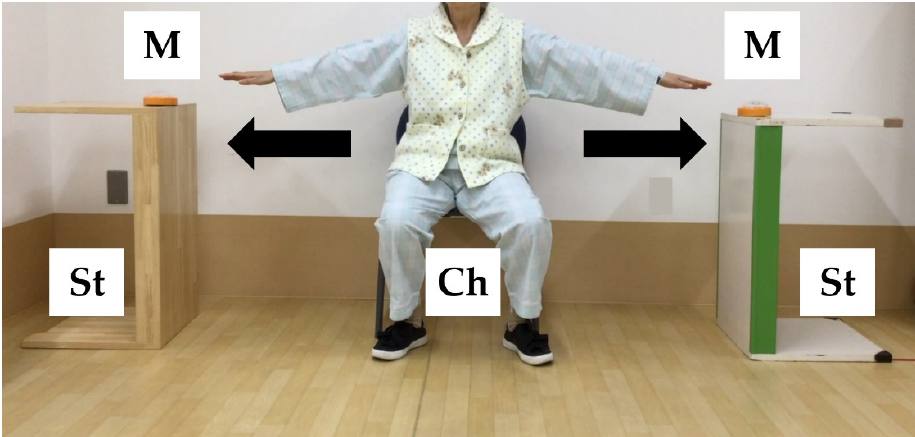
Figure 1. Movements of seated side tapping training. M: marker (diameter, 10 cm); Ch: chair (height, 41 cm from the floor); St: stand (height, 72 cm).